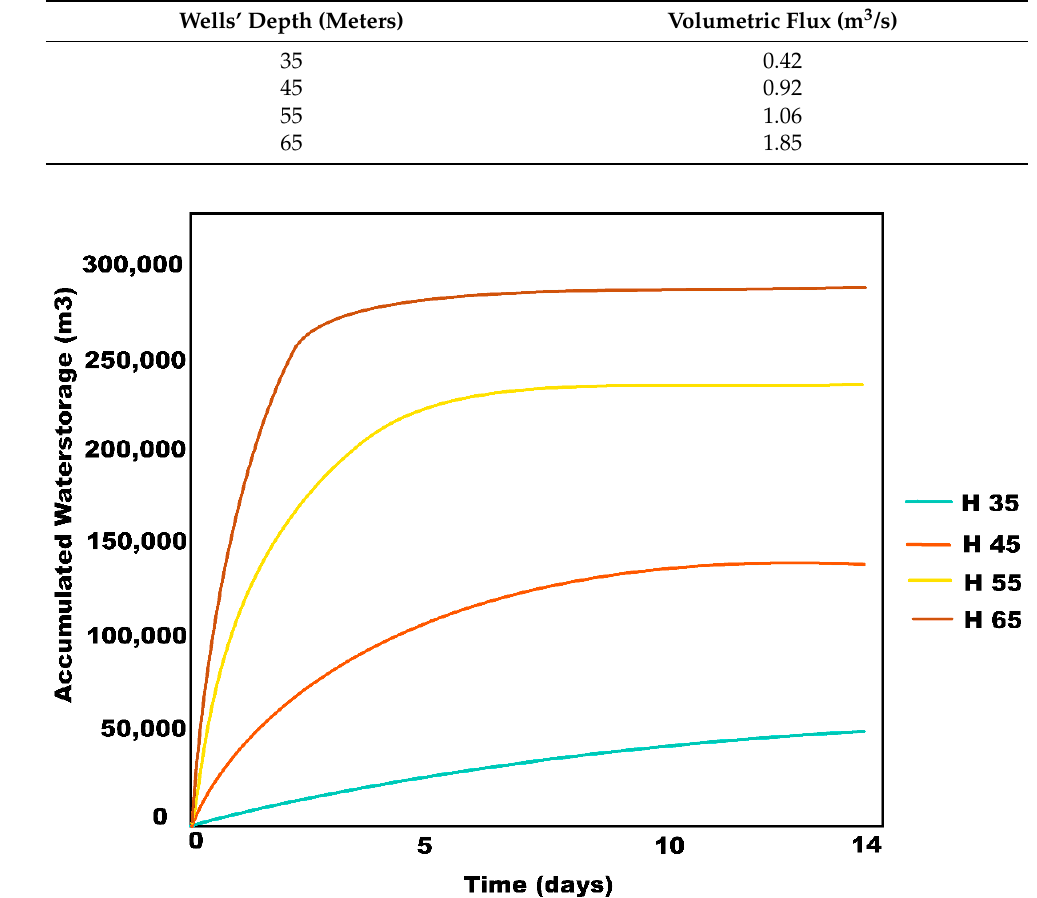
Figure 5. Accumulated water volume for 1 m diameter wells with different depths for 14 days in SEEP/W.